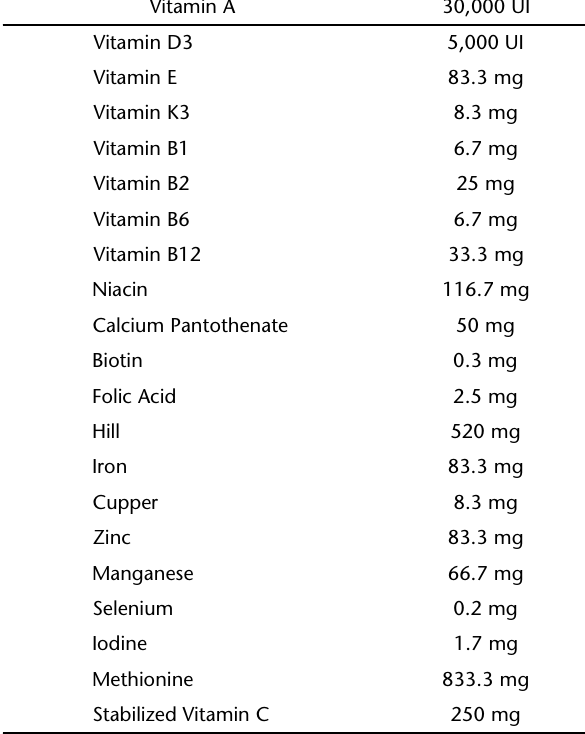
Table I. Composition of the fish food Alcon Basic ® used as organic matter source in the experiments with Limnodrilus hoffmeisteri . Figures provided by the manufacturer (value per kilogram of the